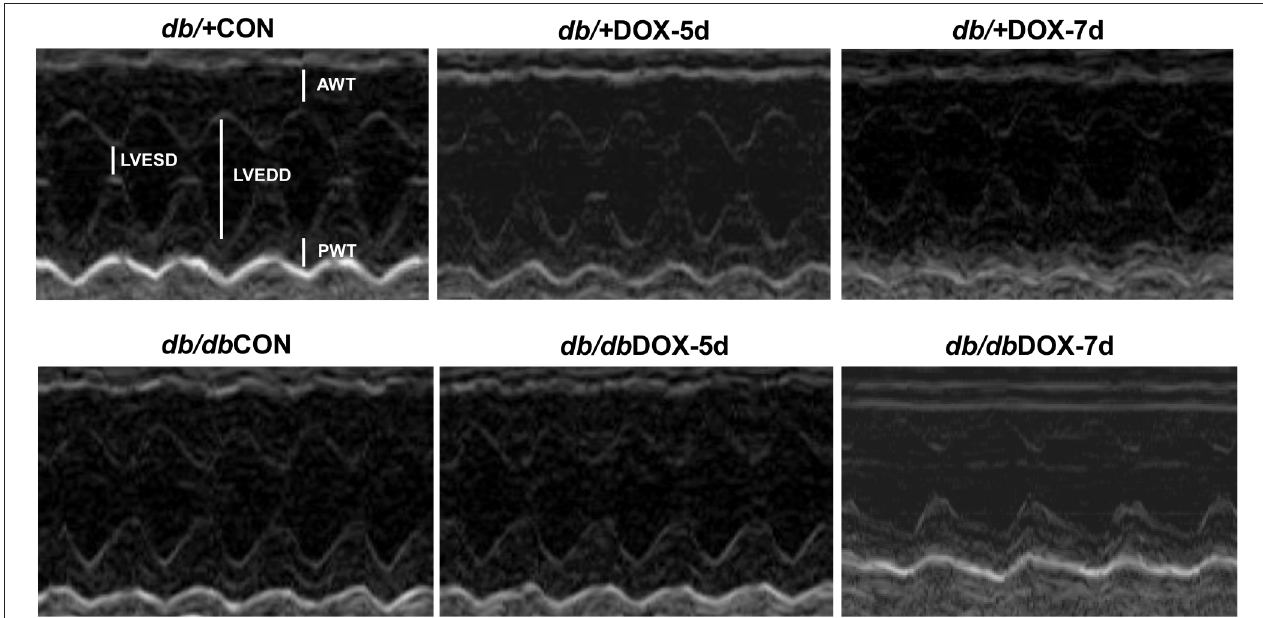
FIGURE 2 | M-mode echocardiographic image. Echocardiography of doxorubicin (DOX)-treated non-diabetic and diabetic mice was performed before and after the 5- and 7-day experimental period to assess the cardiac function. db/ + CON; non-diabetic control group, db/ + DOX-5d, non-diabetic mice on day 5 with treatment of doxorubicin; db/ + DOX-7d, non-diabetic mice on day 7 with treatment of doxorubicin; db/db CON; diabetic control group, db/db DOX-5d, diabetic mice on day 5 with treatment of doxorubicin; db/db DOX-7d, diabetic mice on day 7 with treatment of